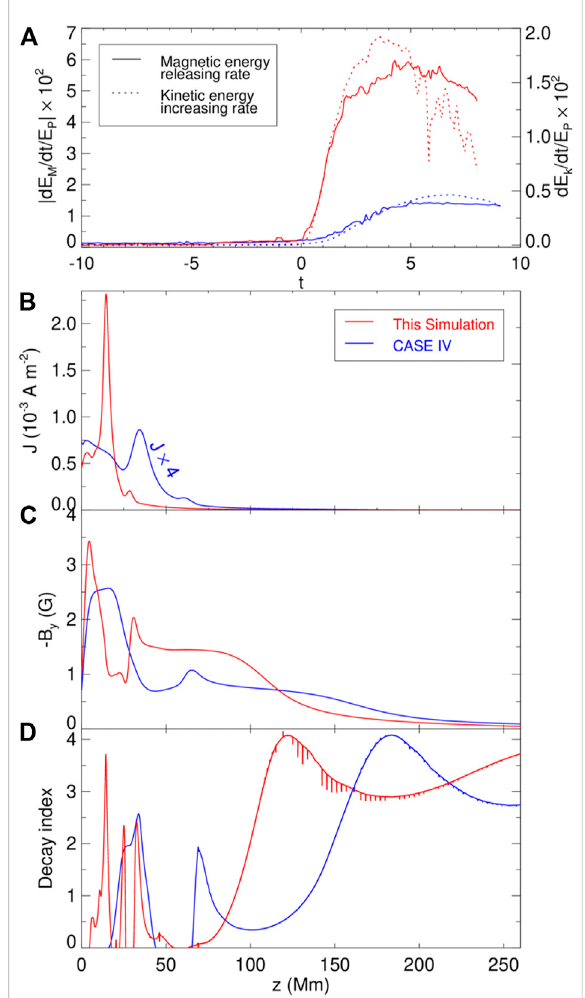
FIGURE 5 Intensity of eruption, current density, magnetic fi eld, and decay index for this simulation and CASE IV. (A) Magnetic energy releasing rate (solid line) and the kinetic energy increasing rate (dotted line). The timescale is shifted so that t = 0 represents the eruption onset. Red and blue curves represent this simulation and CASE IV, respectively. From the top to the bottom are shown for (B) current density, (C) magnetic fi eld component B y , and (D) decay index of B y , along the z -axis, on the eruption onset (this simulation t = 157 and CASE IV t =